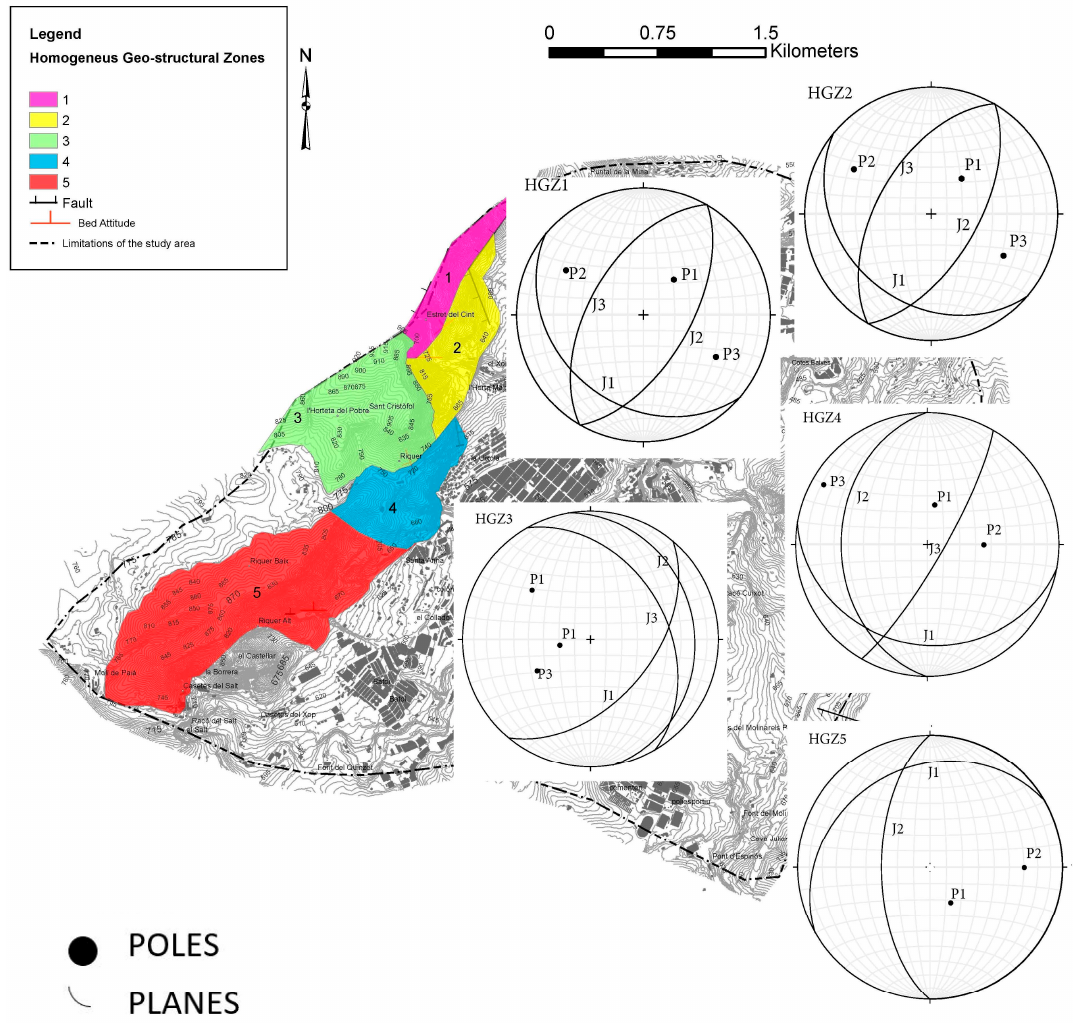
Figure 5. Homogeneous Geostructural Zones (HGZ) resulting for the rock mass outcropping in the Alcoy urban area. The numbers (1 to 5) codify the recognized HGZ.